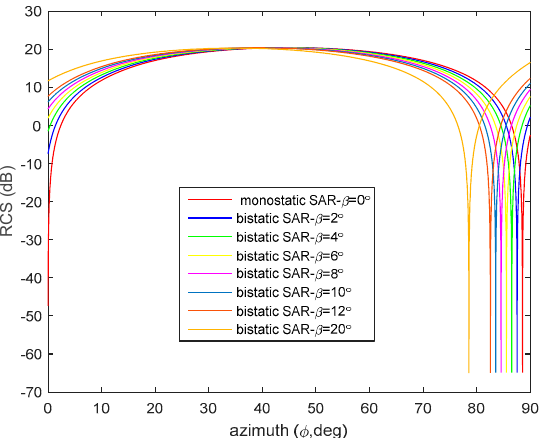
Figure 5. The bistatic RCS azimuth pattern of the TCR based on the monostatic bistatic equivalence theorem.